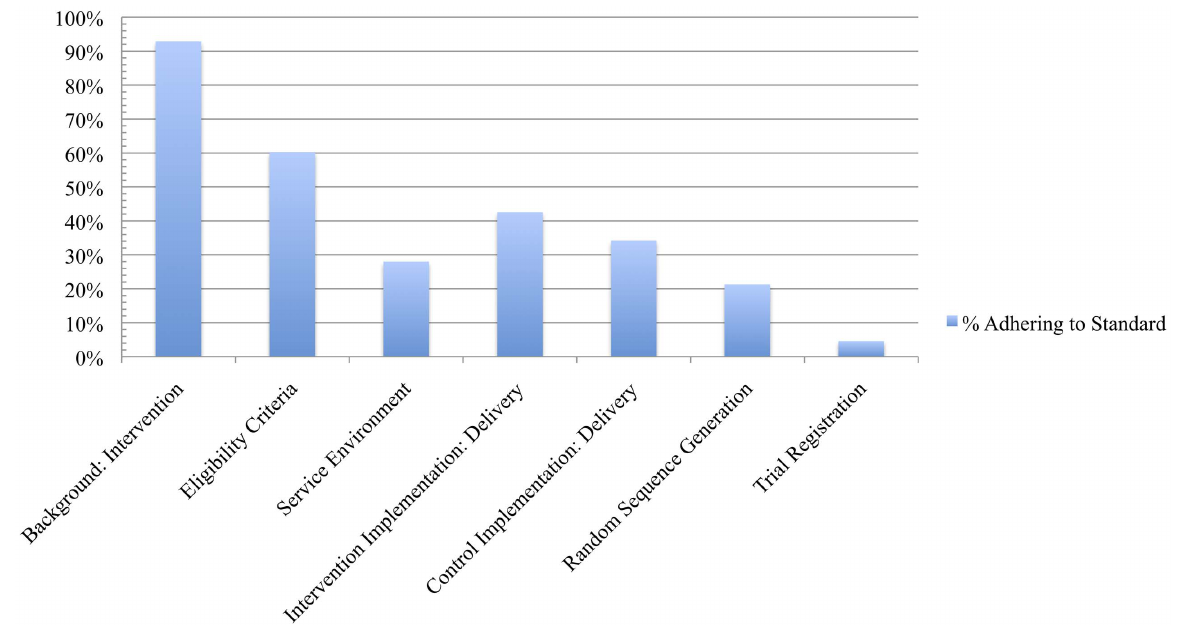
Figure 3. Average compliance of RCTs with key reporting standards.